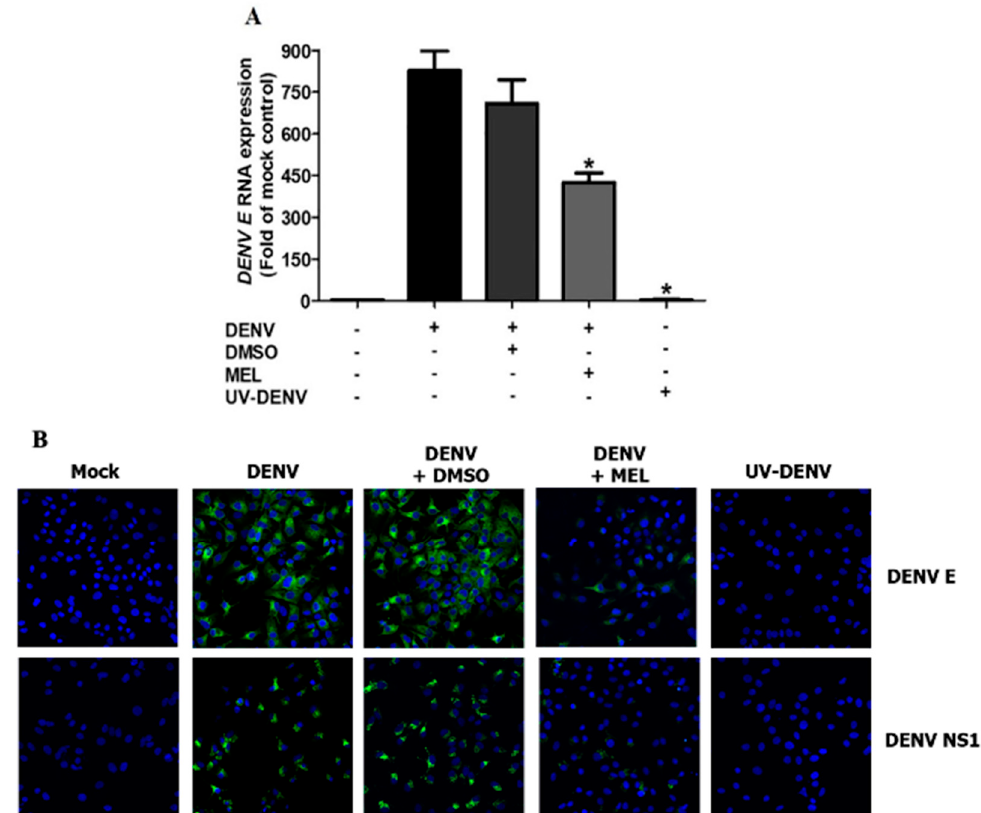
Figure 5. Effect of MEL on DENV RNA and protein expression. Huh7 cells were infected with DENV2 with and without UV-inactivation at MOI 1 and treated with vehicle control or 1000 µ M MEL. ( A ) RNA and ( B ) protein expression was examined at 24 h pi by real time RT-PCR and IFA, respectively. Objective lens (40 × ) were used. The asterisk (*) sign denotes p < 0.05 considered to be statistically significant.